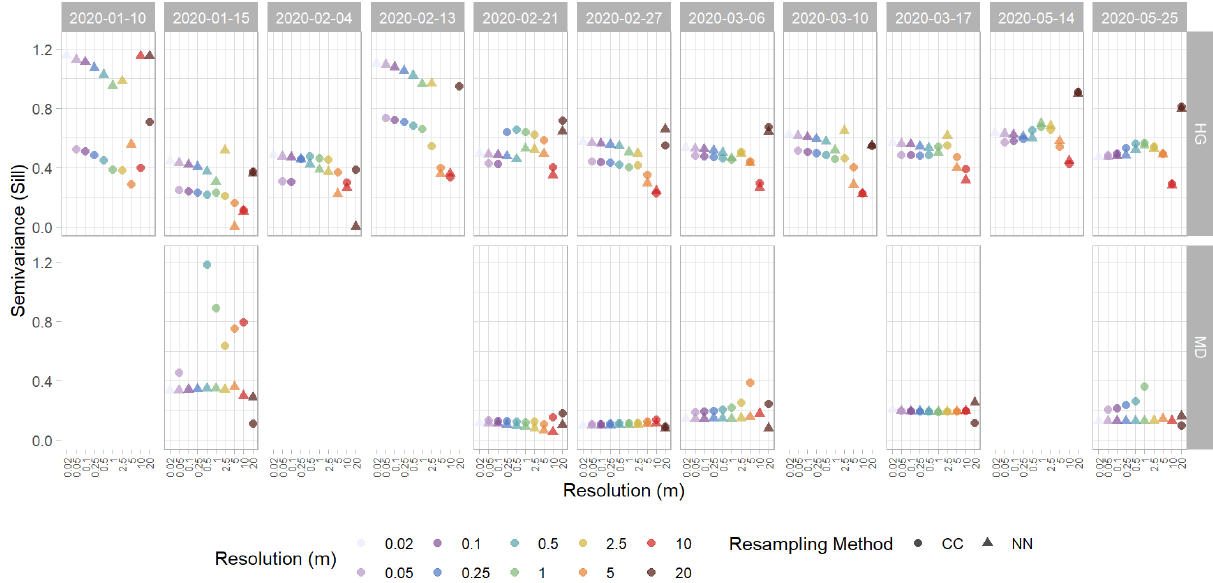
Figure A6. Sill (semivariance) values from spherically fit variograms of detrended snow depth residuals from the Hourglass (HG) and the meadow (MD). Each panel depicts a specific observation day, with circles representing cubic-convolution (CC) resampling methods, triangles representing nearest-neighbor (NN) resampling methods, and colors representing different snow depth DSM resolutions. Five observation days were removed from the meadow site time series due to poor model